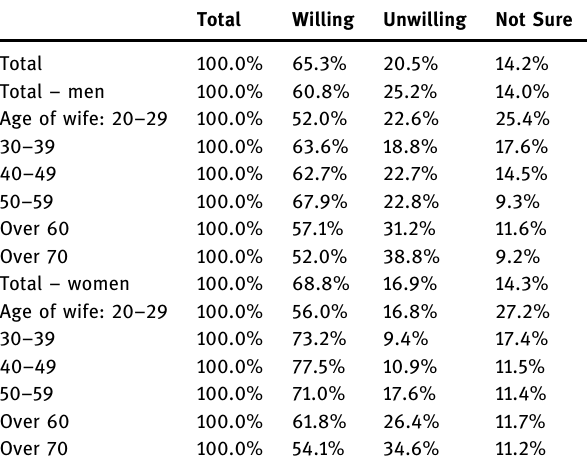
Table 3: Opinions on willingness to live in elderly care